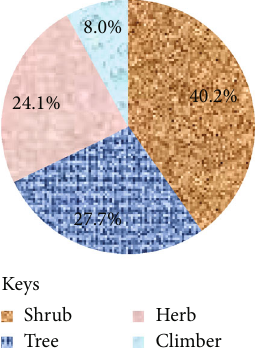
Figure 5: Growth forms of medicinal plants used for the treatment of intestinal